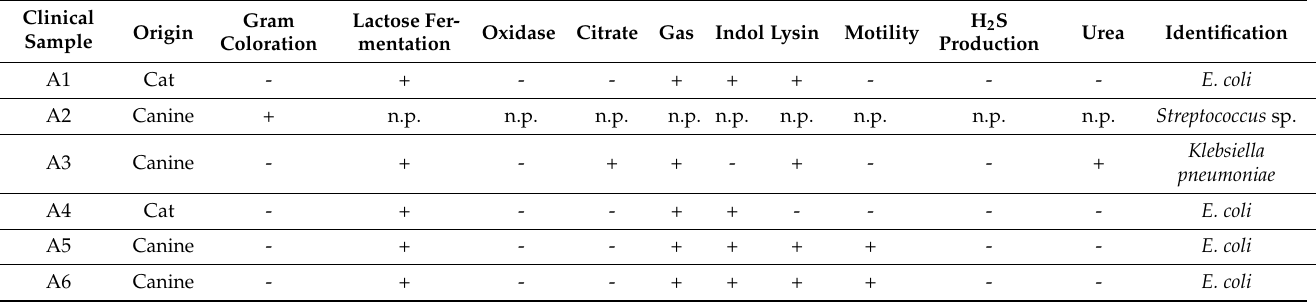
Table 3. Results from the bacterial identification via biochemical tests performed to the colonies isolated from canine uterine samples with pyometra, and from mares.